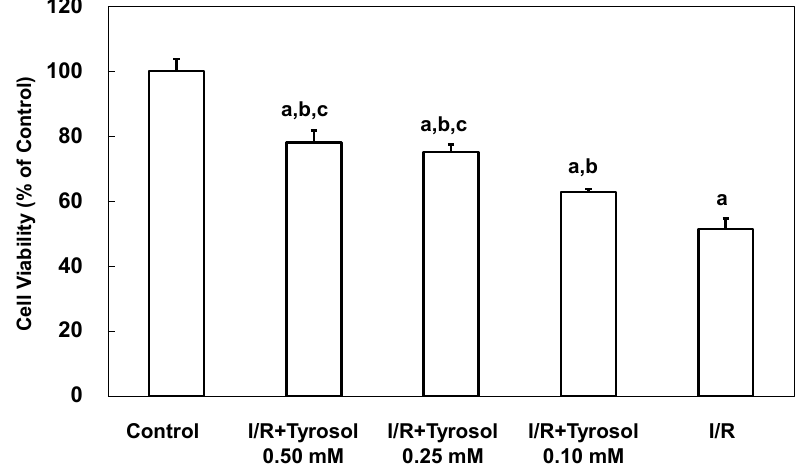
Figure 1. Effect of tyrosol on the viability of H9c2 cardiomyocytes. Cells were